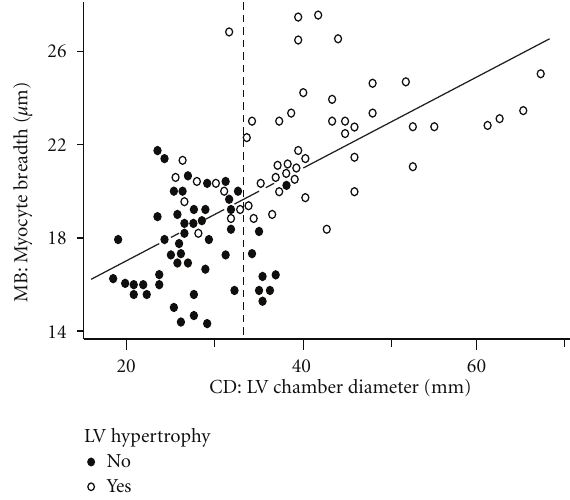
Figure 4: Sloping line plots (3) ( r = 0 . 63).Vertical dashed line plots (4), optimally separating circles from